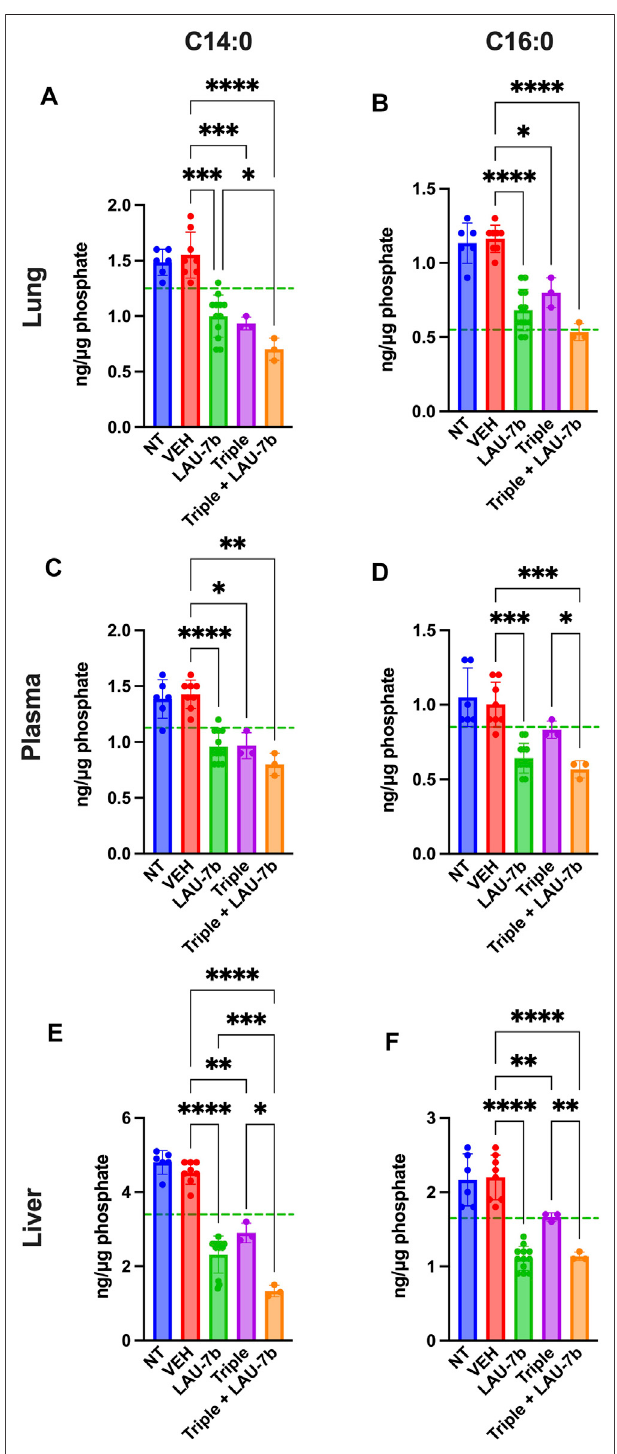
FIGURE6| Decreaseoflong-chainceramides(LCCs)isenhancedupon Triple therapy and LAU-7b combination in the lungs, plasma, and liver of F508del/F508del (DD) mice. Mass spectrometry analysis of mouse lungs (A,B) , plasma (C,D) , and liver (E,F) . LAU-7b treatment signi fi cantly decreases LCCs C14:0 and C16:0 when compared to vehicle (VEH) treated